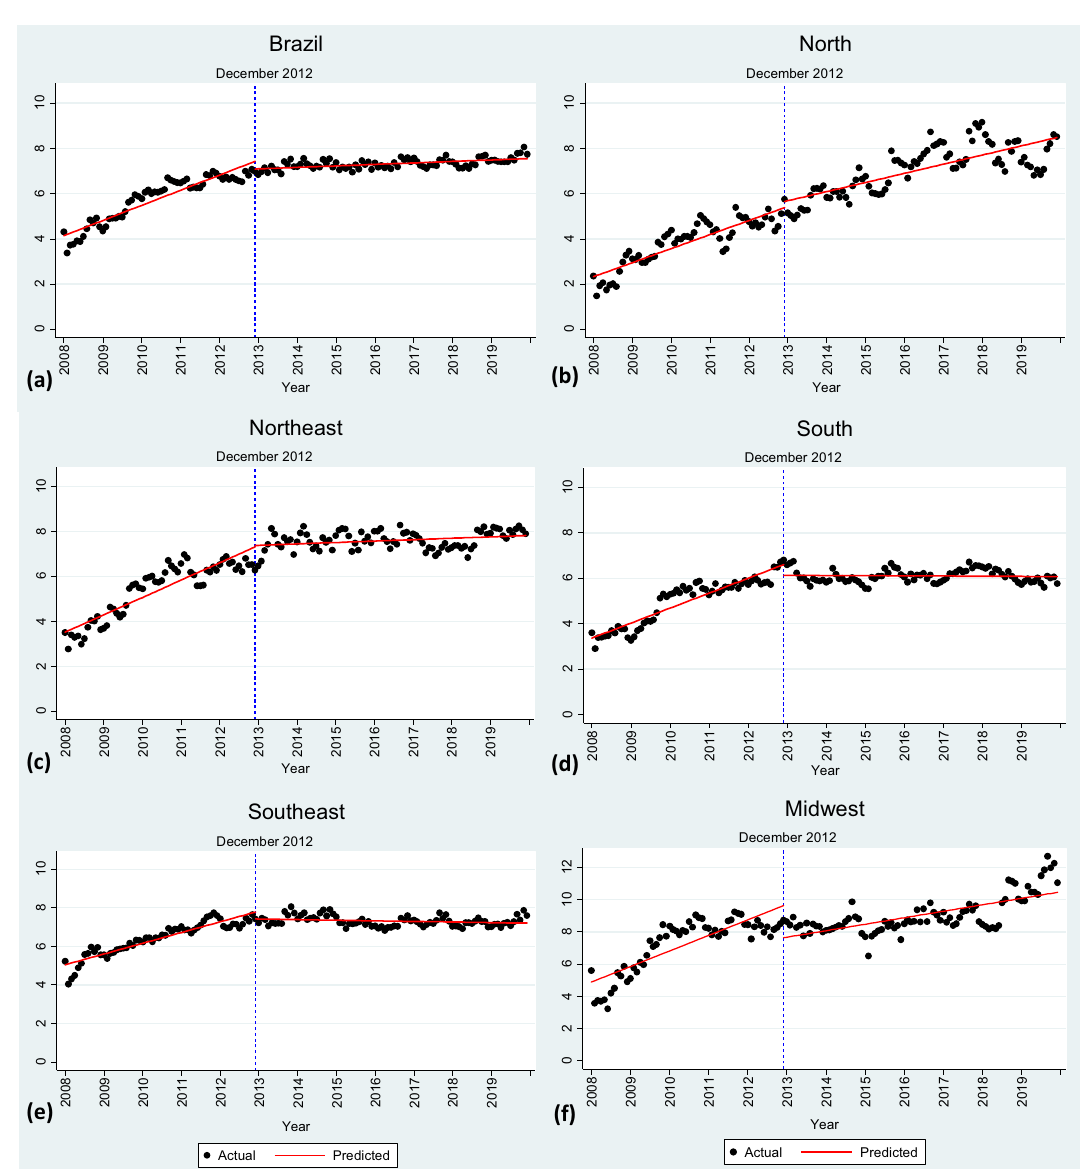
Figure 2. Graphical representation of the new zero-tolerance drinking and driving law on hospital rate for land transport accidents from interrupted time series regression for Brazil ( a ) and its regions ( b – f ),